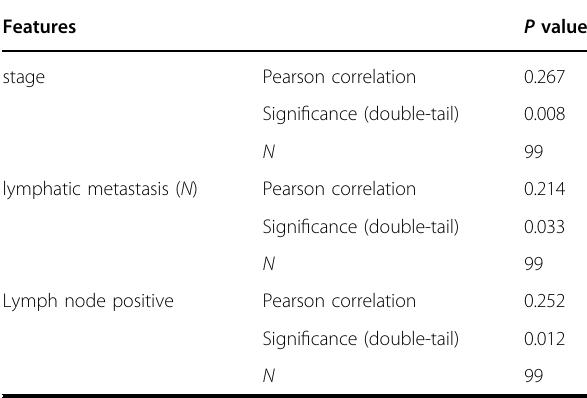
Table 3 Relationship between DPP3 expression and tumor characteristics in patients with colorectal